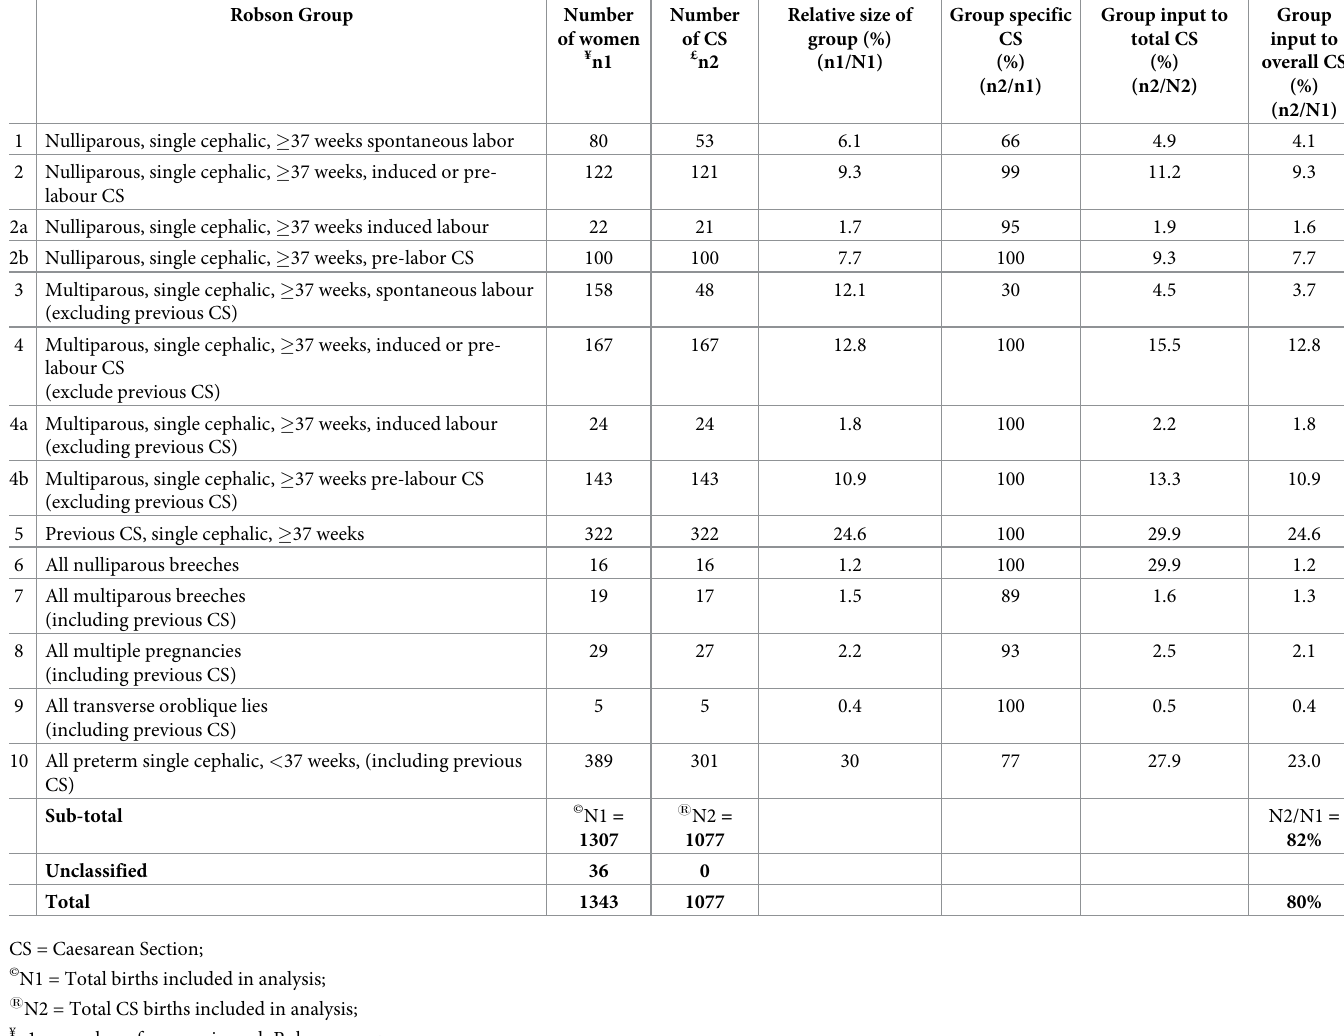
Table 1. Robson ten obstetric groups and their contribution to overall Caesarean section (CS) rate. Robson